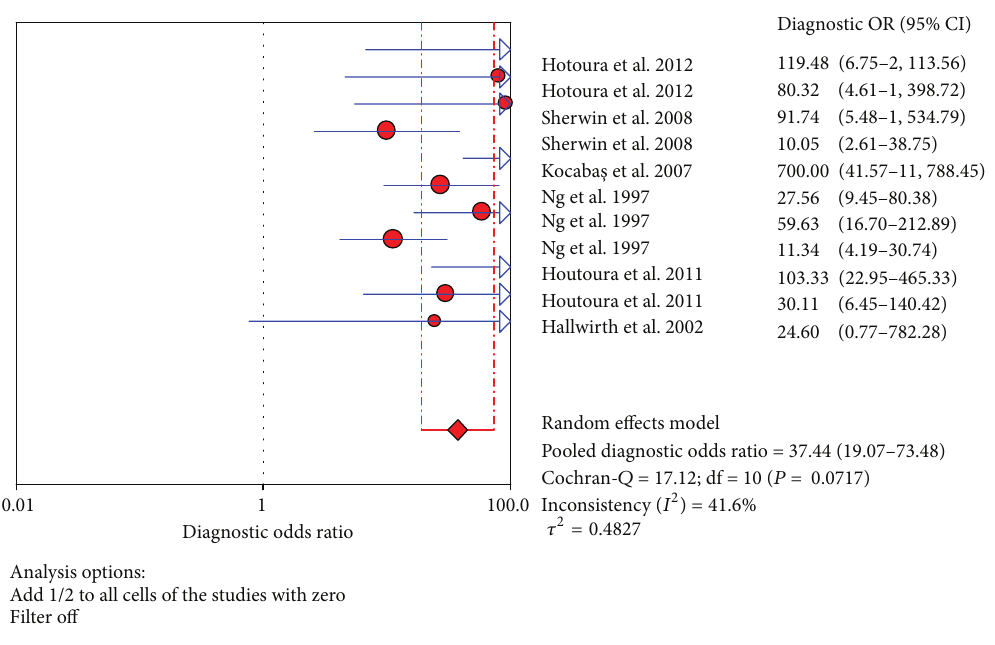
Figure 6: Forest plot for diagnostic OR of the TNF- 𝛼 test to diagnose neonatal sepsis at the LONS.